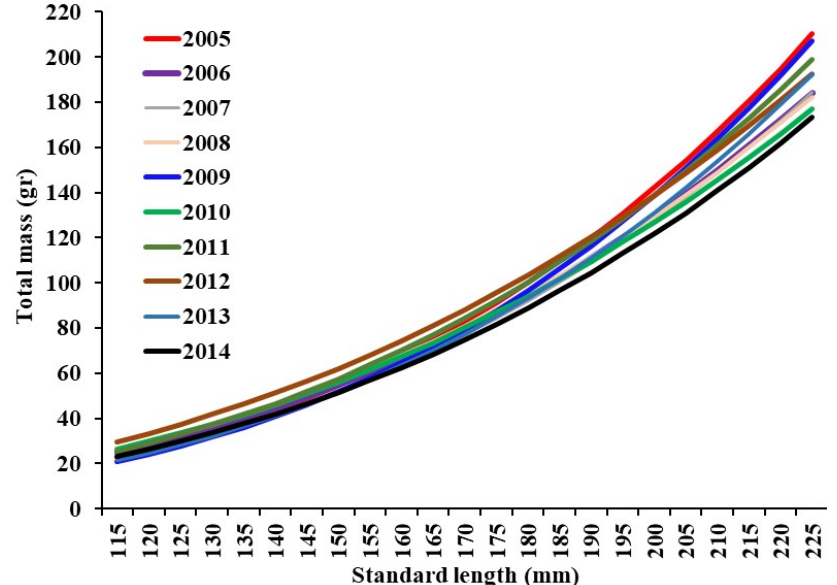
Figure 4. Total body mass and standard length ( TM – SL ) relationship per year for the Sardinops sagax temperate stock in the southern California Current System (CCS). Parameters a and b are presented in Table